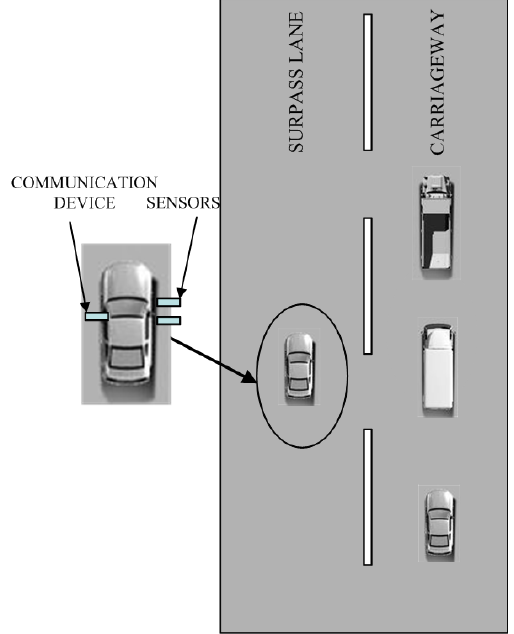
Figure 1. Ultrasonic sensor system for highway vehicle TRV